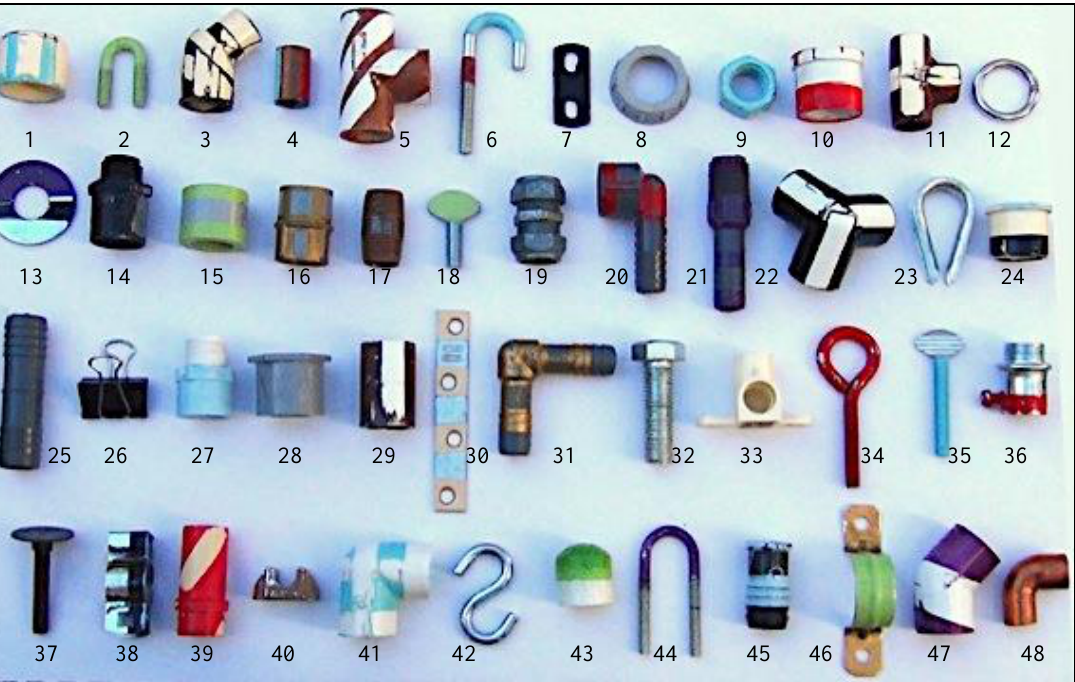
Figure 2 . Set of hardware objects used in Study 1. There were 24 items for each category (PVC or metallic). In details, PVC objects: 1, 3, 5, 8, 10, 11, 14, 15, 16, 20, 21, 22, 24, 25, 27, 28, 29, 31, 33, 39, 41, 43, 45, 47. Metallic objects: 2, 4, 6, 7, 9, 12, 13, 17, 18, 19, 23, 26, 30, 32, 34, 35, 36, 37, 38, 40, 42, 44, 46, 48. See Supplemental Material for details on object